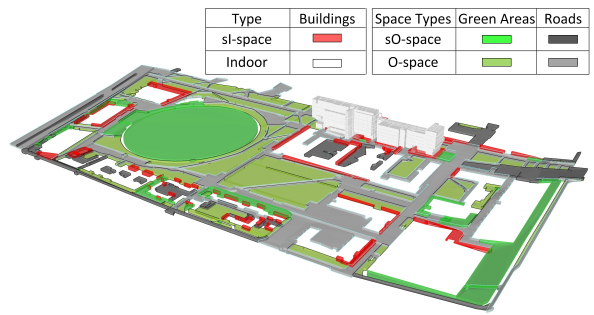
Figure 9. BIM spaces and created 3D spaces in the test area.